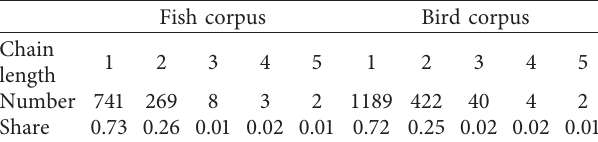
Figure 5: Comparison of word sense disambiguation results. Table 1: MOAS chain length